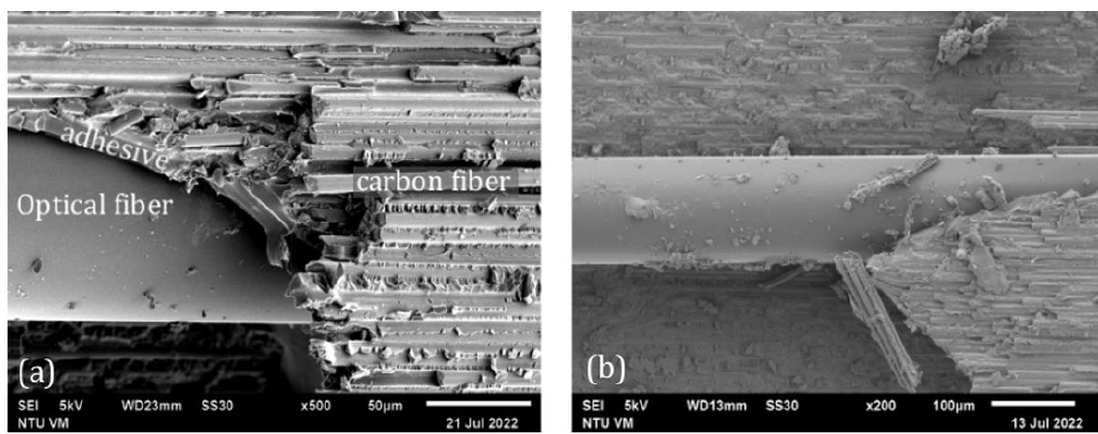
Figure 9. Typical SEM fractographs from two progressively loaded tensile specimens. ( a ) higher magnification; ( b )lower magnification.